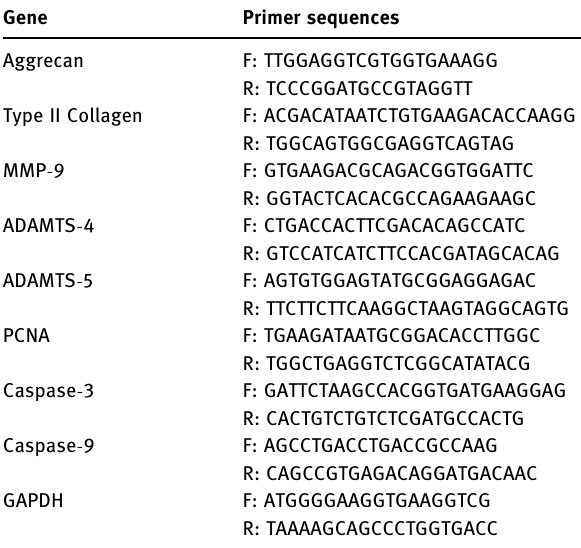
Table 1: Primer sequences used for qPCR